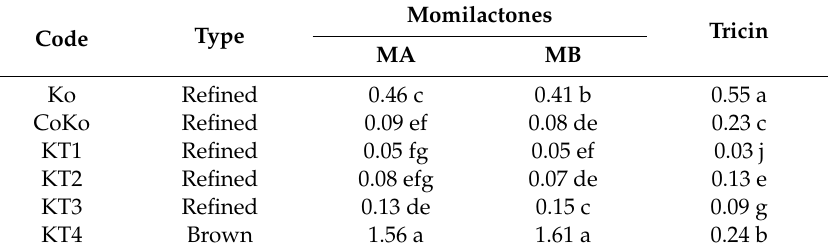
Table 4. Momilactones A, B, and tricin contents ( µ g / g DW) in various rice